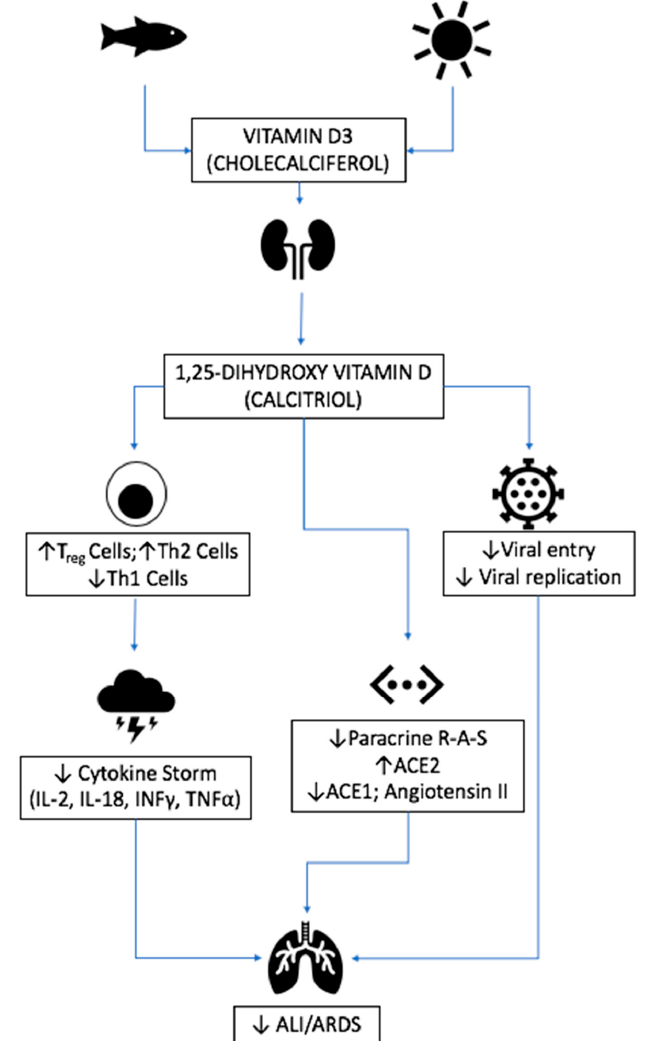
Figure 8. Vitamin D and potential anti-COVID19 mechanisms of action. Vitamin D derivatives are thought to mediate the immune system responses to infective agents through enhanced Treg and Th2 cell function, attenuating the cytokine storm that is thought to be a key pathogenic mechanism in ARDS. Other speculated roles include the protection against lung injury through modulating the pulmonary renin-angiotensin system and reducing viral entry and replication.